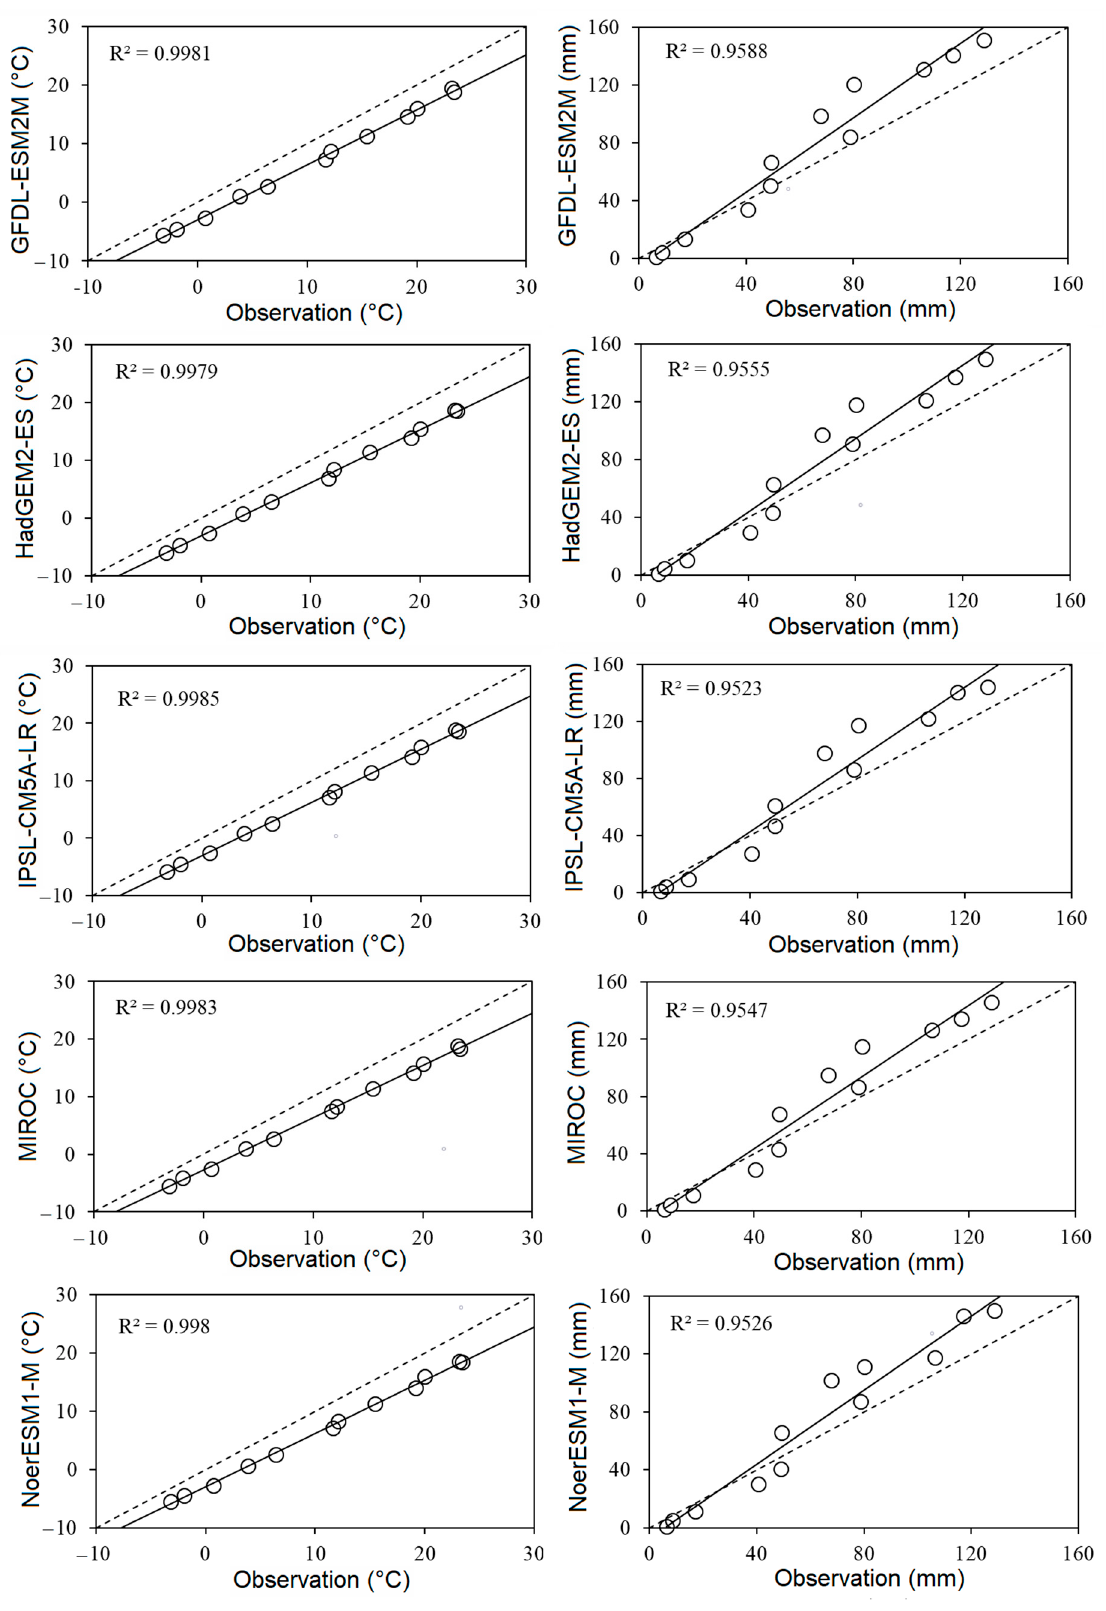
Figure 5. All GCM monthly mean temperature ( figures on the left side ) and accumulated precipitation ( figures on the right side ) from 1966 to 2004 at the Rasht climate station in the Vakhsh River Basin, Central Asia.